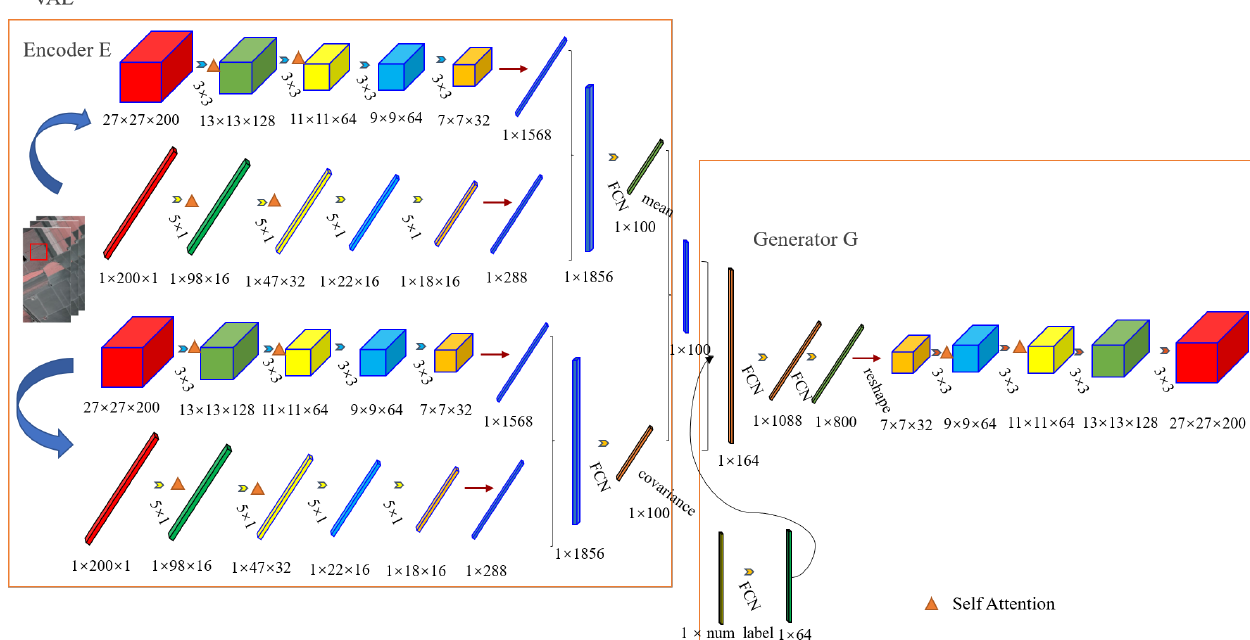
Figure 4. The structure of the VAE